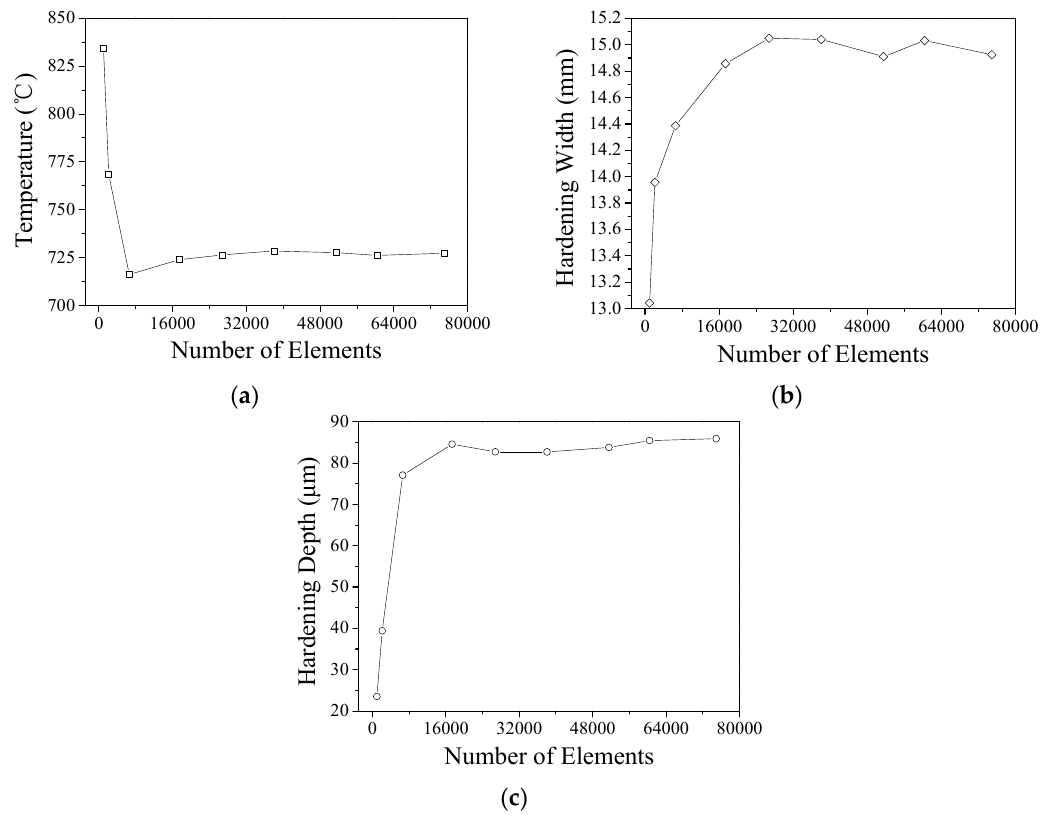
Figure 7. ( a ) Convergence analysis with temperature; ( b ) Convergence analysis with hardening width; and ( c ) Convergence analysis with hardening